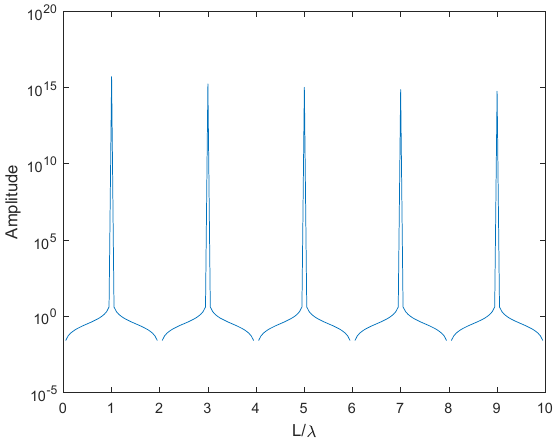
Figure 2. Radiation capability (x-mode dipole).